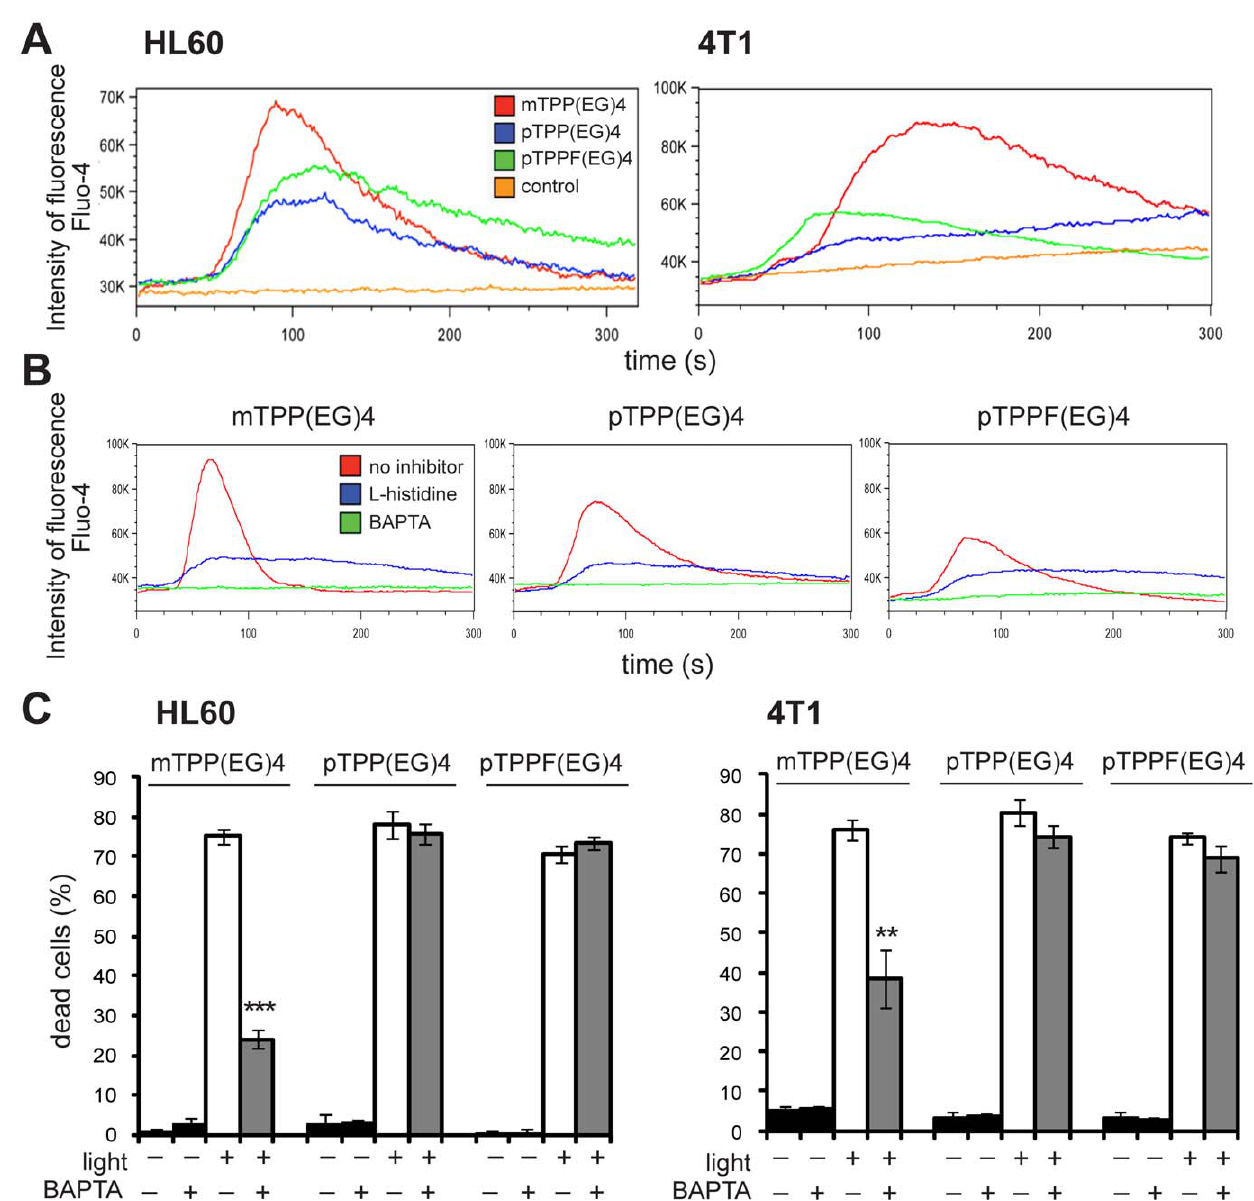
Figure 4. The role of Ca 2 + in photoinduced apoptosis by EG-porphyrin derivatives. ( A ) Intracellular calcium levels in HL60 and 4T1 cells. The effect EG-porphyrin derivatives on cytosolic Ca 2 + levels was monitored by flow cytometry of laser-illuminated cells containing fluorescent Ca 2 + indicator Fluo-4-AM (4 m M) (Molecular Probes). Cells treated in the same way but without porphyrin were used as controls. ( B ) Effect of BAPTA and L- histidine on the intracellular Ca 2 + level. HL60 cells were loaded with EG-porphyrin derivatives for 16 h, washed and then preincubated for 1 h with ROS scavenger L-histidine (20 mM) or 2 h with calcium chelator BAPTA-AM (5 m M). The cytosolic Ca 2 + level was monitored by flow cytometry using fluorescent Ca 2 + indicator Fluo-4-AM (4 m M). ( C ) Effect of BAPTA-AM preincubation on photoinduced apoptosis. Cells loaded with EG-porphyrin derivatives were pre-incubated with the membrane-permeable intracellular Ca 2 + chelator BAPTA-AM (5 m M HL60, 10 m M 4T1) for 2 h to inactivate released Ca 2 + and then irradiated with 2.5 Jcm 2 2 of light at 500 6 20 nm. This corresponds to an LD 70 PDT dose. Cell viability was determined 24 h post-photodynamic therapy by the trypan blue exclusion method. The percentage of dead cells was expressed as mean 6 SD (n=4). **P , 0.01, ***P , 0.001 represents statistical differences between PDT-treated cells vs. PDT-treated cells in the presence of BAPTA-AM.